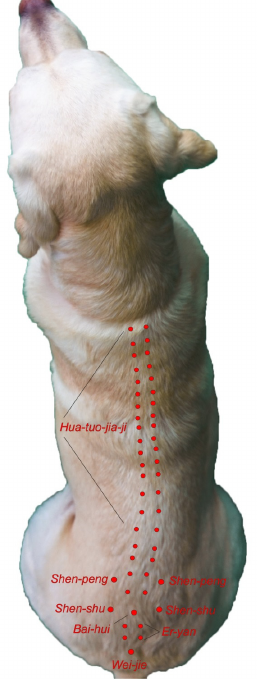
Figure 2. Extra Meridian Points with Classical Chinese Names. Reprinted with permission from Ref. [29]. 2018, Dewey C and Xie S.